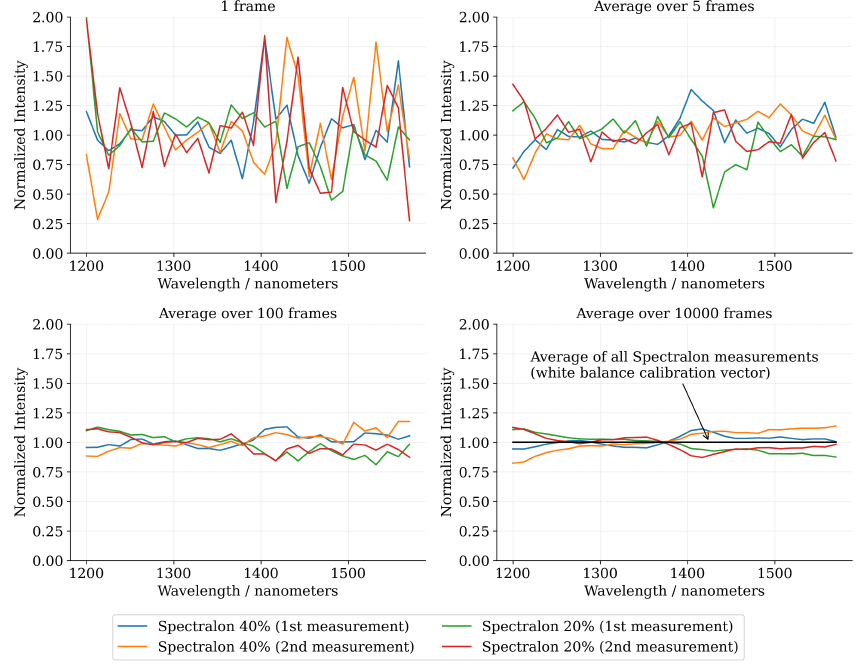
Figure 11. The relative spectral reflectance curves of the Spectralon targets with various block sizes. The white balance calibration vector has been computed as an average over the signal-magnitude normalized Spectralon spectra S n with the frame count set at N frames = 10,000 in order to maximize the signal-to-noise ratio. The bottom-right figure illustrates the average of the four Spectralon spectra as a black curve, which is by definition identity at all wavelength channels (The black curve is equivalent to the relative spectral reflectance curve of the white balance